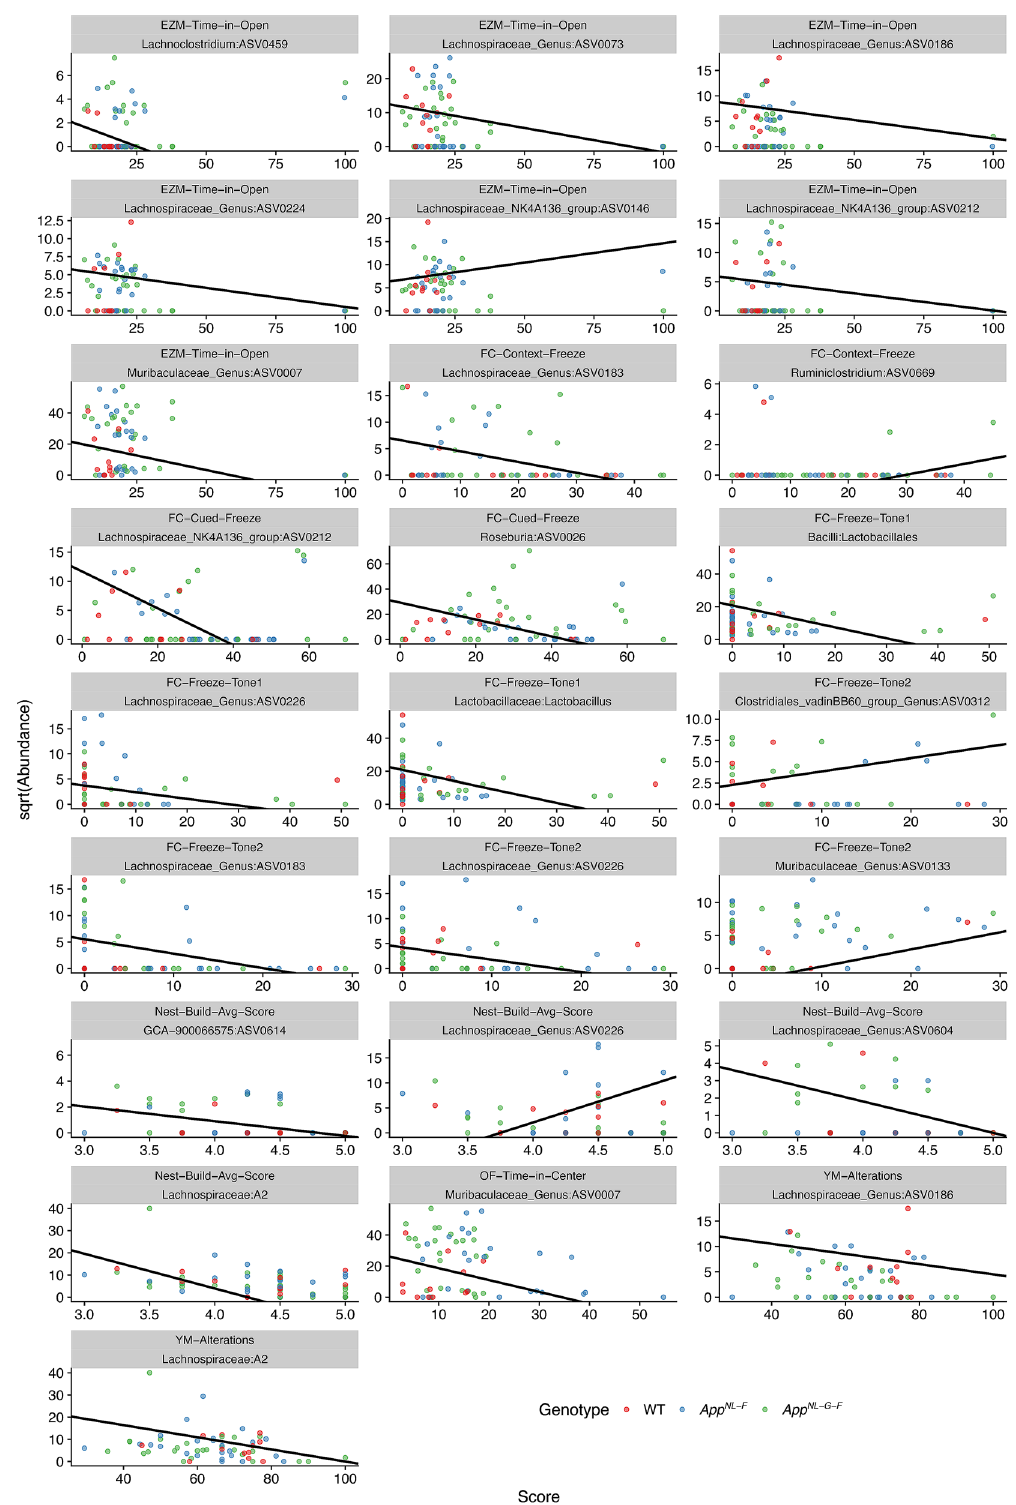
Figure 7. Scatter plots for associations between various behavioral scores (x-axes) and the square root of various taxon abundances (y-axes) found significant utilizing compound Poisson generalized linear models. Black lines indicate the estimated slopes and y-intercepts for each association. Points are colored by mouse genotype: WT (red), App NL-F (blue), App NL-G-F (green). App NL-G-F mice: n = 13 females and 14 males; App NL-F mice: n = 11 females and 14 males; WT mice: n = 11 females and 11